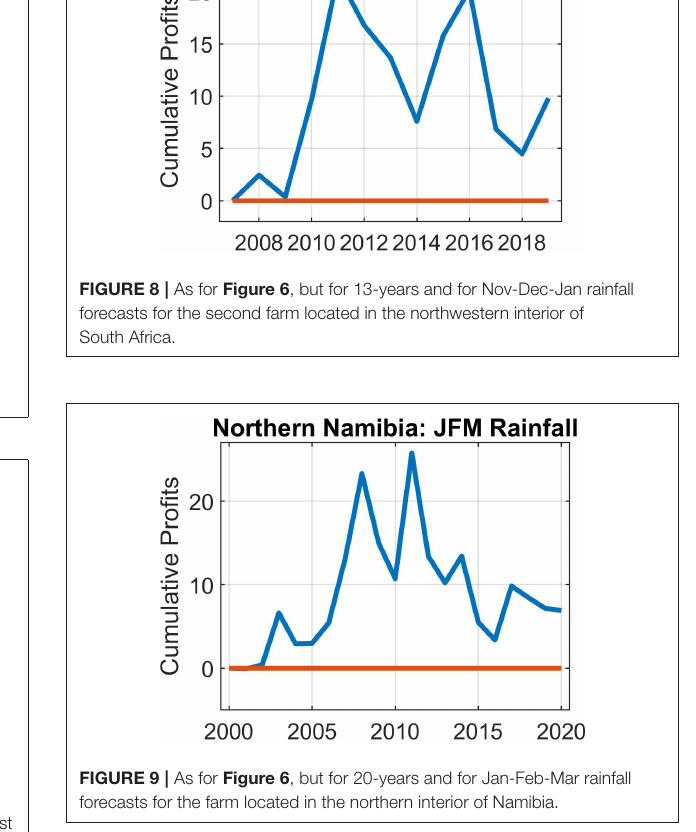
FIGURE 7 | As for Figure 6 , but for Nov-Dec-Jan rainfall forecasts for the first farm located in the northwestern interior of South Africa.